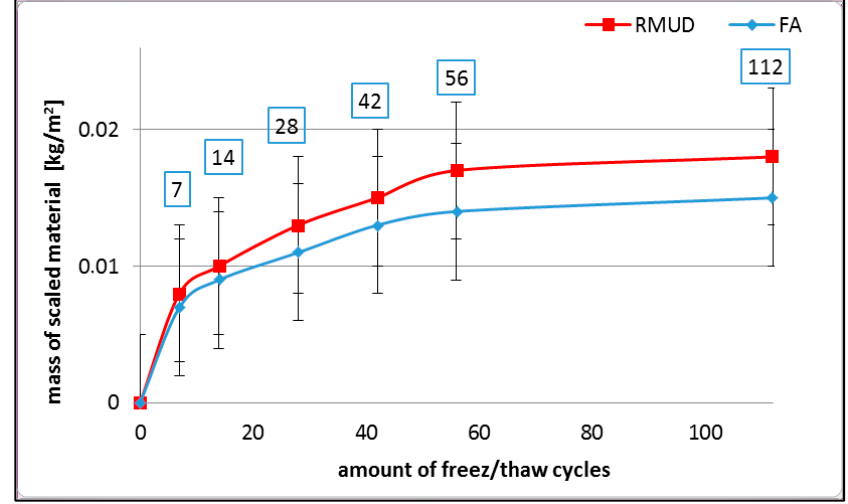
Figure 5. Scaling of tested concrete.